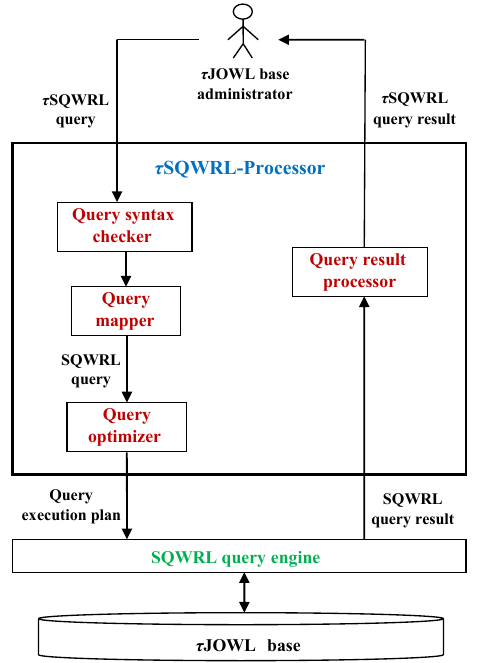
Fig. 2 Architecture of the (cid:28)(cid:28)(cid:28) SQWRL-Processor